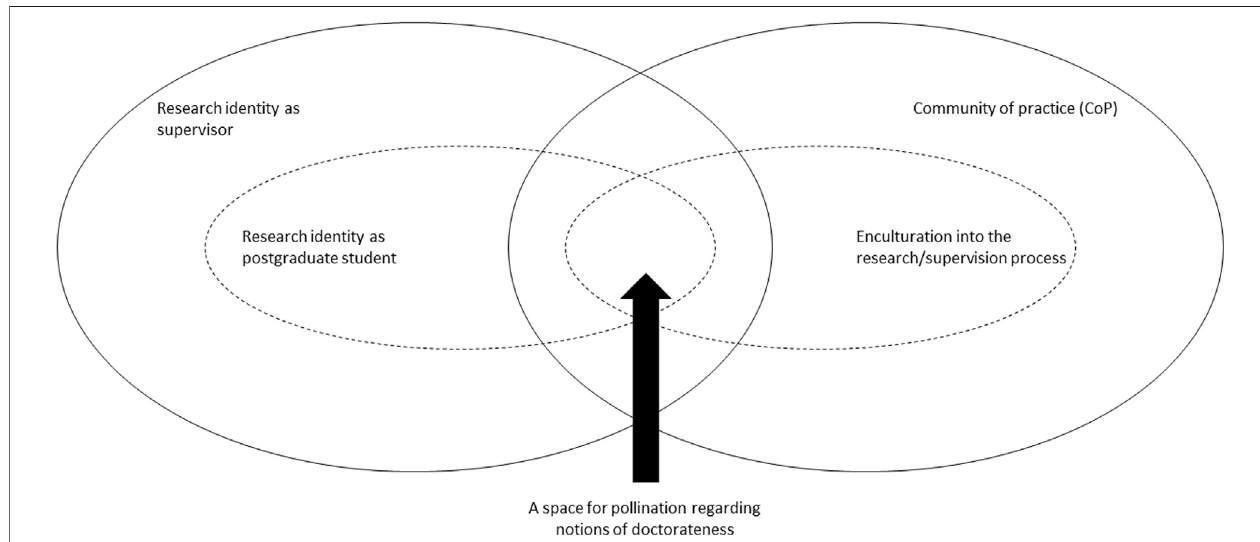
FIGURE 1 | Depiction of the positioning of a platform like Twitter within notions of